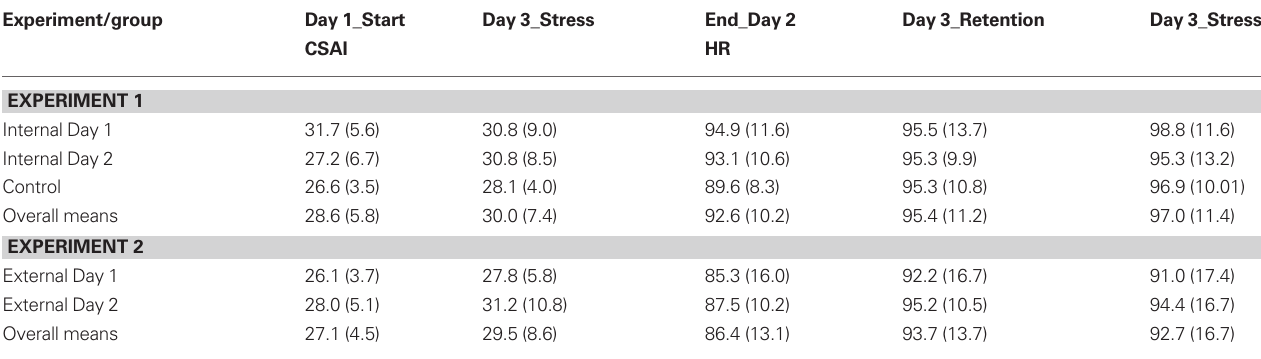
Table 2 | average heart rate data (bpm) and scores on the cognitive and somatic subscales of the cSai-2 (and SDs) as a function of group and testing day and/or condition across the two